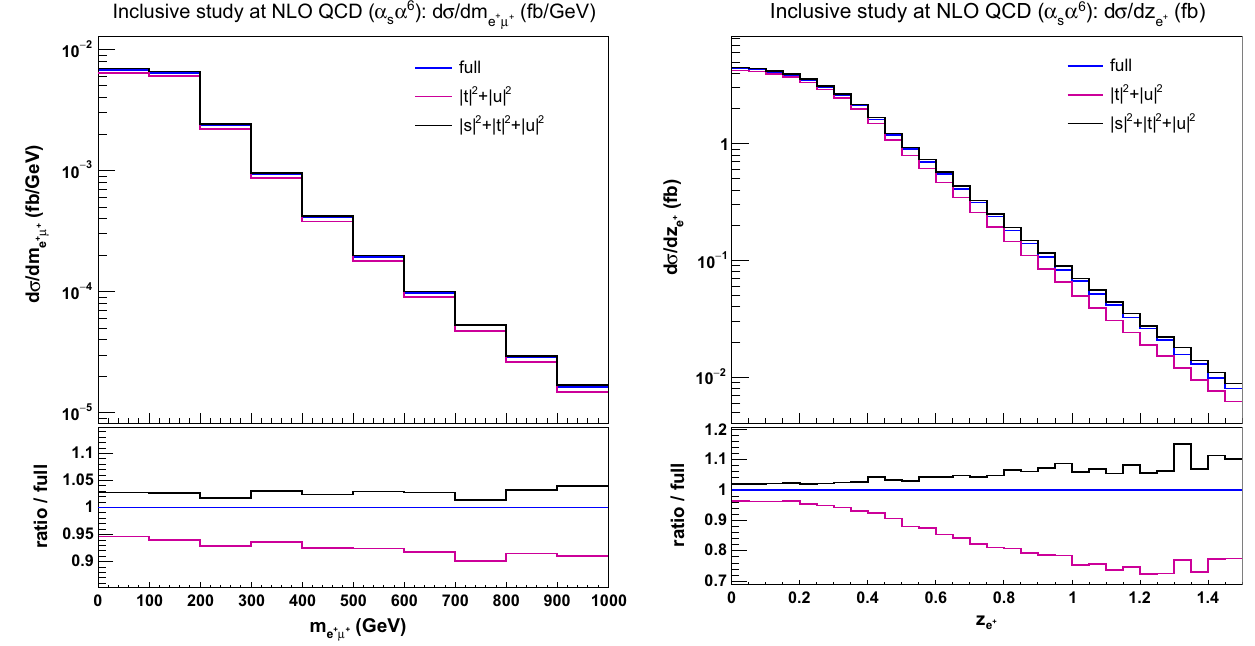
Fig. 9 Differential distributions in the lepton-lepton invariant mass (left) and the electron Zeppenfeld variable (right) at NLO QCD i.e. at order O (α s α 6 ) for the full computation and two approximations. The upper plots provide the absolute value for each prediction while the